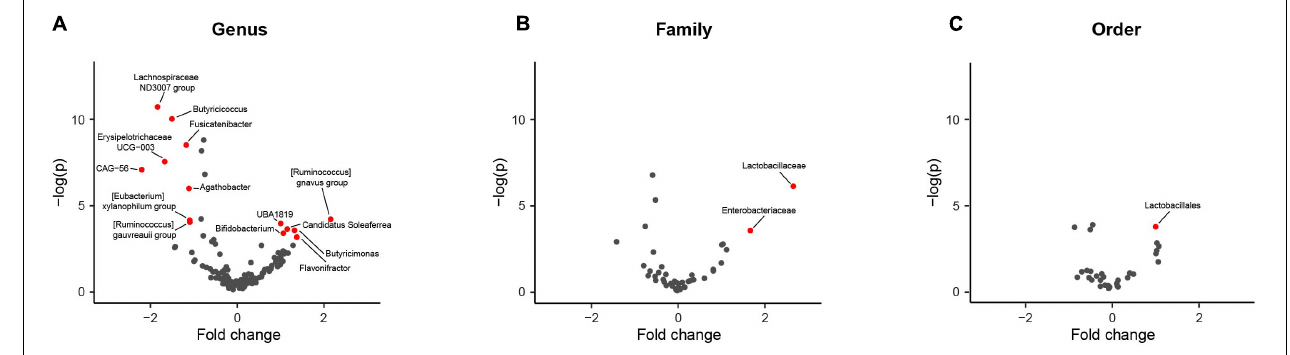
FIGURE 3 | Comparison of taxa abundance between household (HC) and Parkinson’s disease (PD) patients at different phylogenetic levels reveals specific differences. Volcano plots representing abundance differences (fold change) of different taxa between HC and PD patients showed statistically significant [-log ( p ) > 3; fold change > ± 1.2] compositional differences at the genus, family and order levels (represented by red dots), indicative of a PD-related GM composition. With regards to PD patients, there was statistically significant overrepresentation of Bifidobacterium , Candidatus Soleaferre, Butyricimonas, Flavonifractor, [Ruminococcus] gnavus group, and Faecalibacterium sp. UBA1819 and underrepresentation of Butyricicoccus, Fusicatenibacter, Lachnospiraceae ND3007 group , Erysipelotrichaceae UCG-003 , Agathobacter , [Eubacterium] xylanophilum group , [Ruminococcus] gauvreauii group, and Firmacutes bacterium CAG:56 at the genus level (A) , overrepresentation of Lactobacillaceae and Enterobacteriaceae at the family level (B) and overrepresentation of Lactobacillales at the order level (C) . The largest fold change was observed for increased Lactobacillaceae taxa abundance (2.7 fold increase).